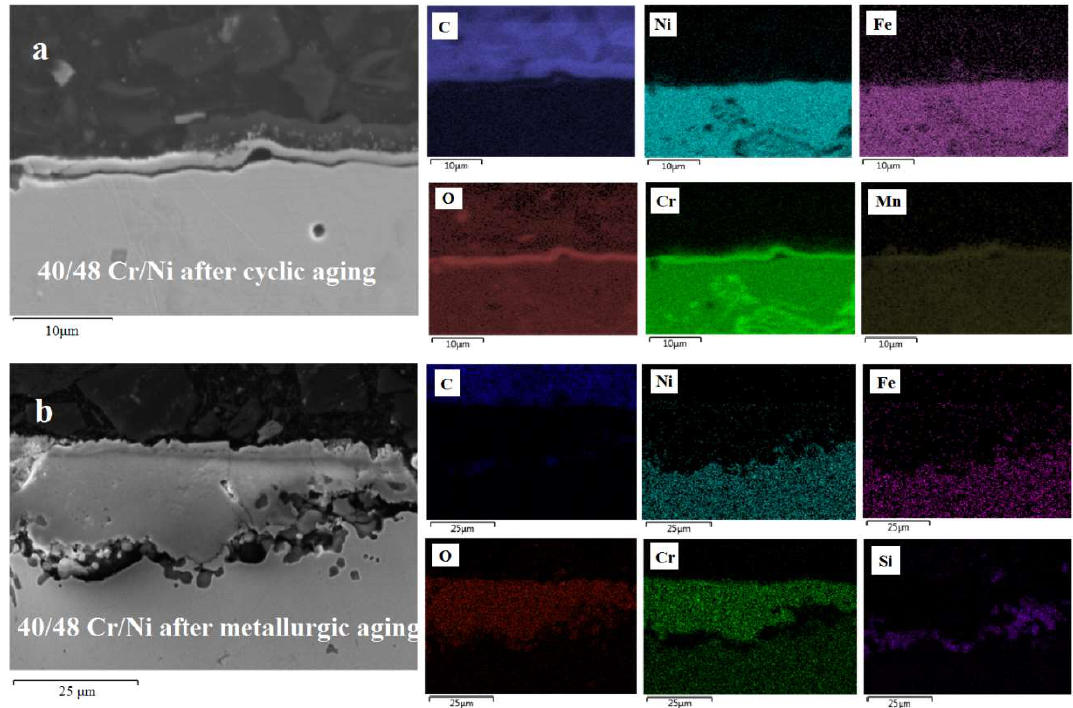
Figure 11. SEM-EDX images of a 40/48 Cr/Ni alloy after cyclic aging ( a ) and after metallurgic aging ( b ). Magnification: 3000× ( top ) and 1500× ( bottom ), Accelerating Voltage: 15 kV.